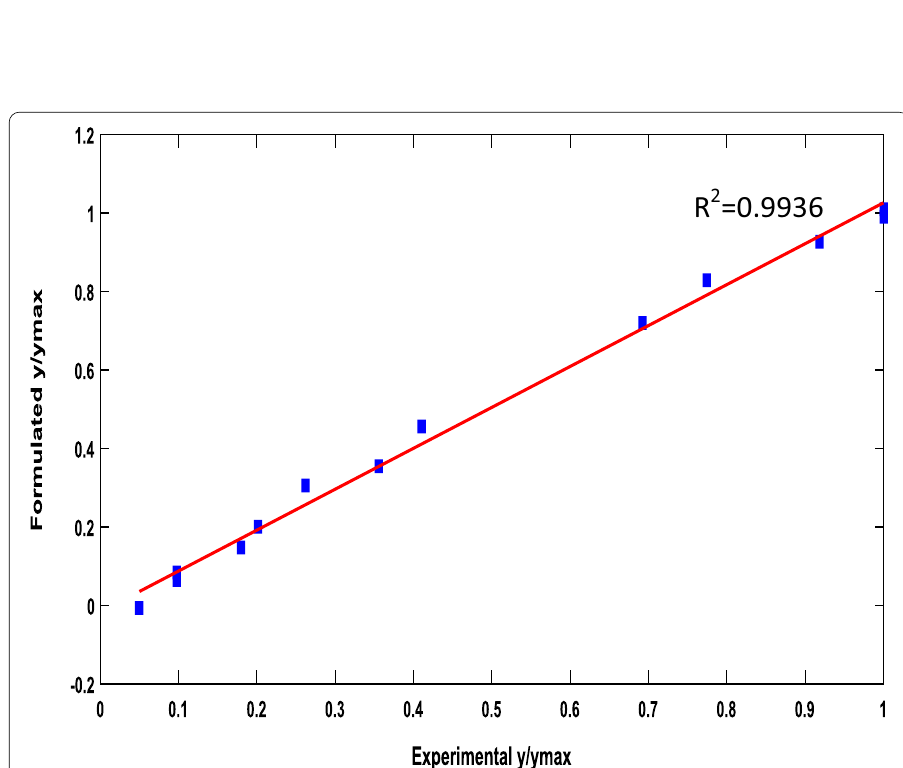
Fig. 16 Scatter plot for y/y max in single pile in reverse